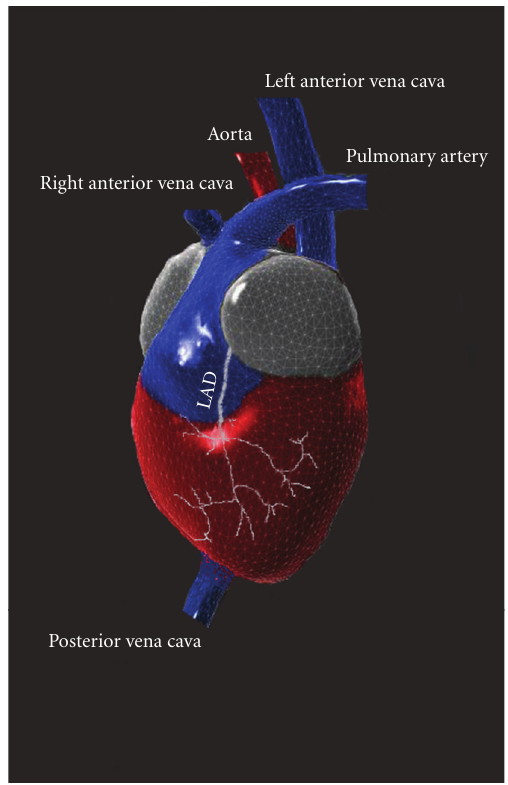
Figure 2: Tridimensional reconstruction of mouse heart, represent- ing the peculiar features of venous pole and left coronary artery